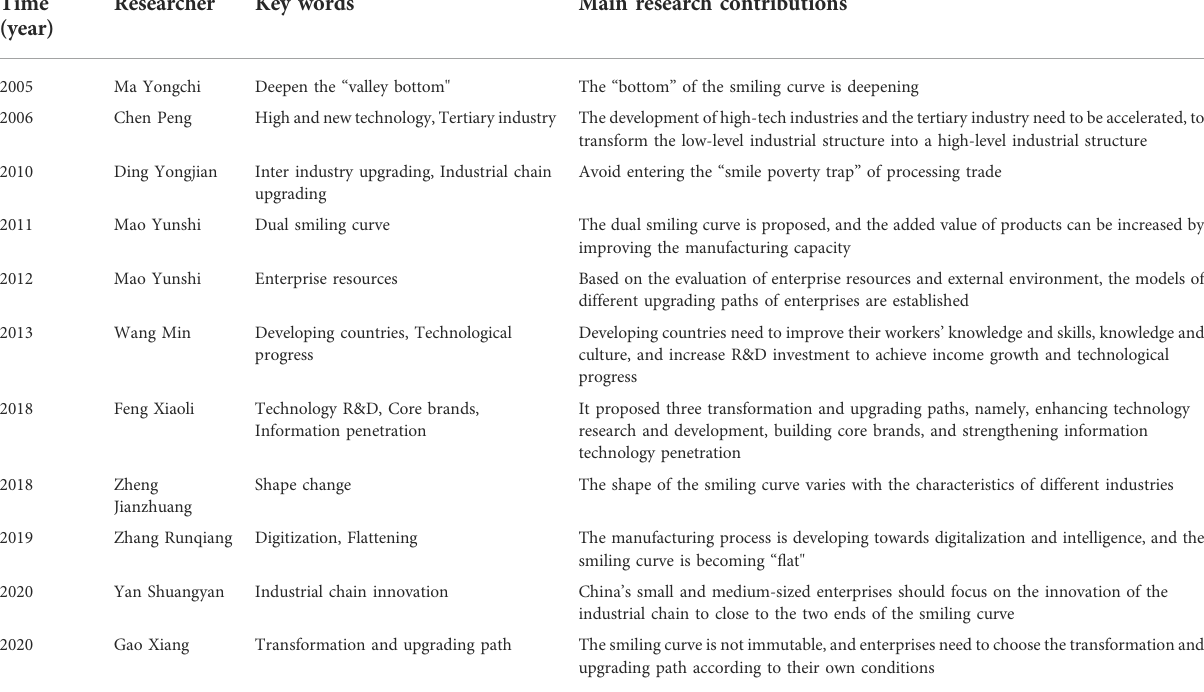
TABLE 1 Main research achievements of smiling